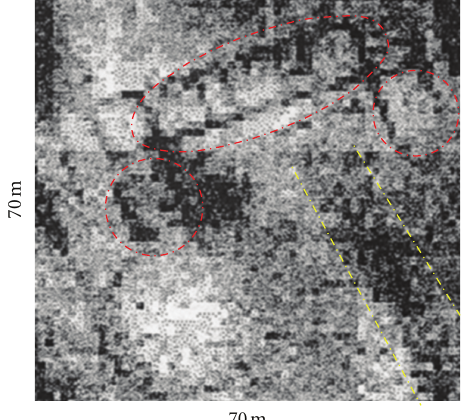
Figure 6: Resistivity Survey of Barcombe Romano-British Villa. The corridor between the wings of the villa is put into evidence by the red dashed tilted ellipse, the ditch is outlined by the yellow dashed lines, and the wings of the villa by the red dashed circles.